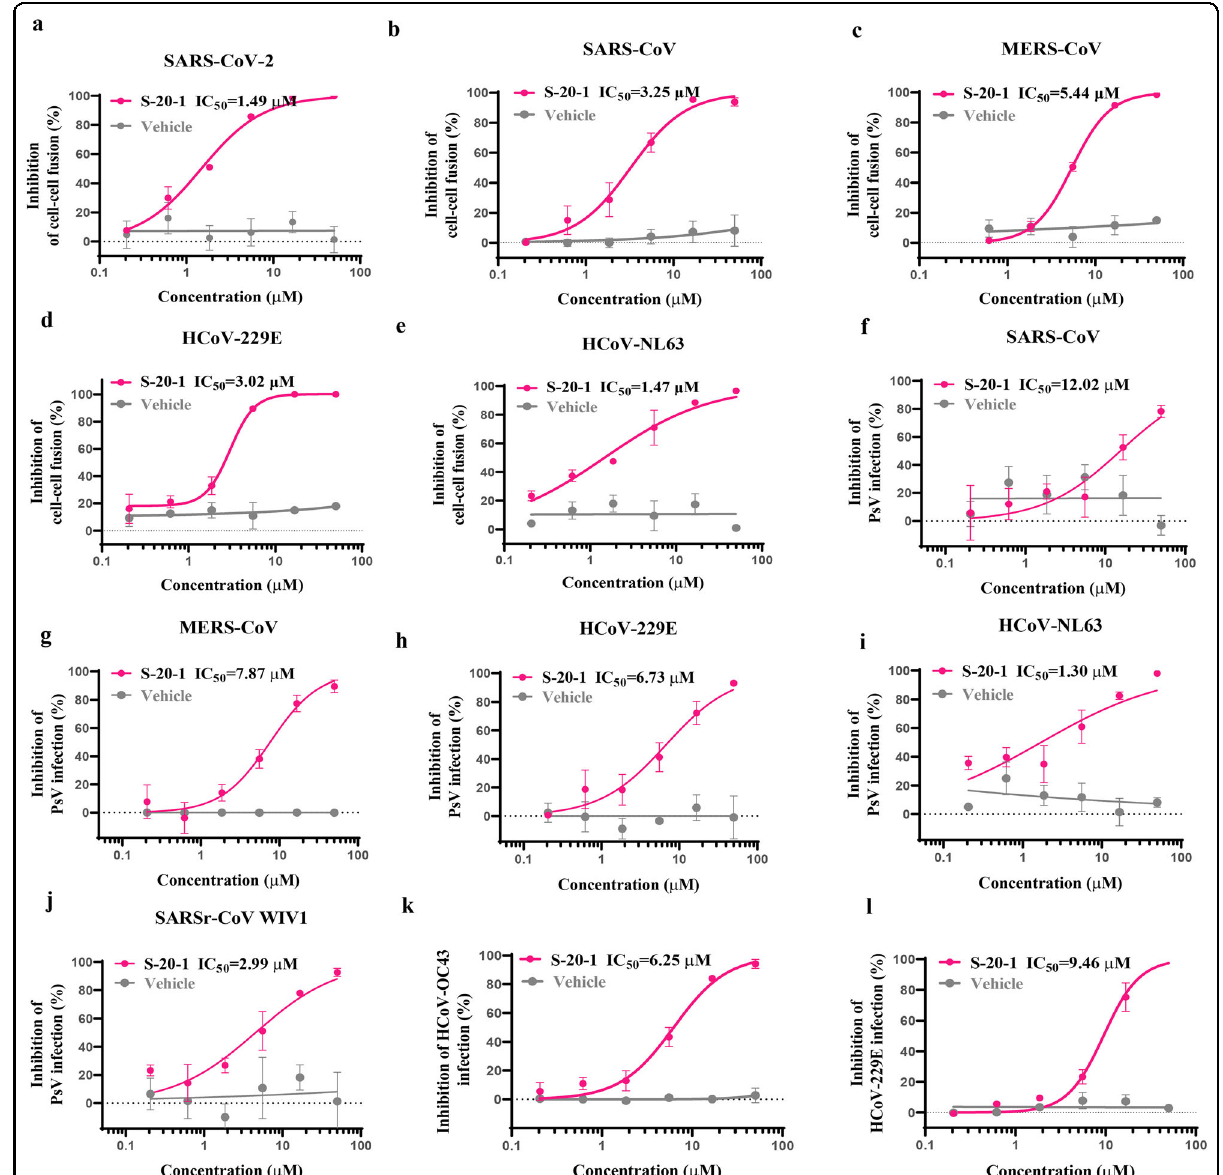
Fig. 4 Inhibition of S-20-1 against infection of divergent HCoVs and SARSr-CoV. Inhibitory activity of S-20-1 on cell – cell fusion mediated by the S protein of SARS-CoV-2 ( a ) SARS-CoV ( b ) MERS-CoV ( c ) HCoV-229E ( d ) and HCoV-NL63 ( e ) Inhibitory activity of S-20-1 against infection of pseudotyped SARS-CoV ( f ) MERS-CoV ( g ), HCoV-229E ( h ), HCoV-NL63 ( i ) and SARr-CoV W1V1 ( j ). Inhibitory activity of S-20-1 against infection of authentic HCoV-OC43 ( k ) and HCoV-229E ( l ). RD cells and Huh-7 cells were infected with HCoV-OC43 ( k ) and HCoV-229E ( l ),